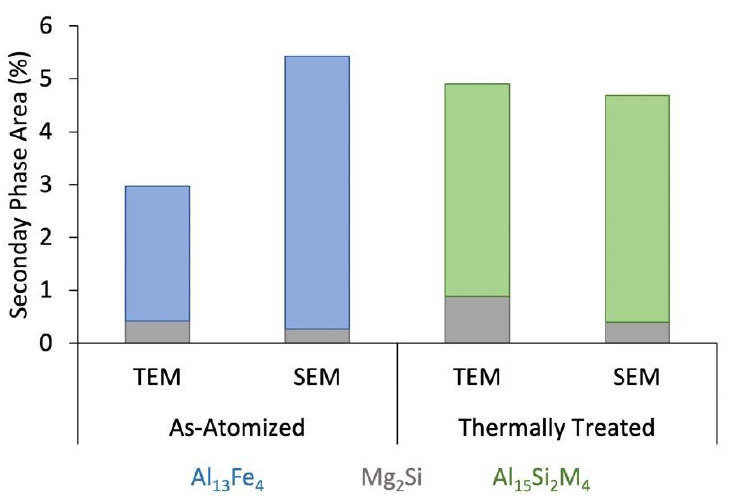
Figure 10. Secondary phase area percentages were determined for the as-atomized and thermally treated conditions via both SEM (points) and TEM (bars).